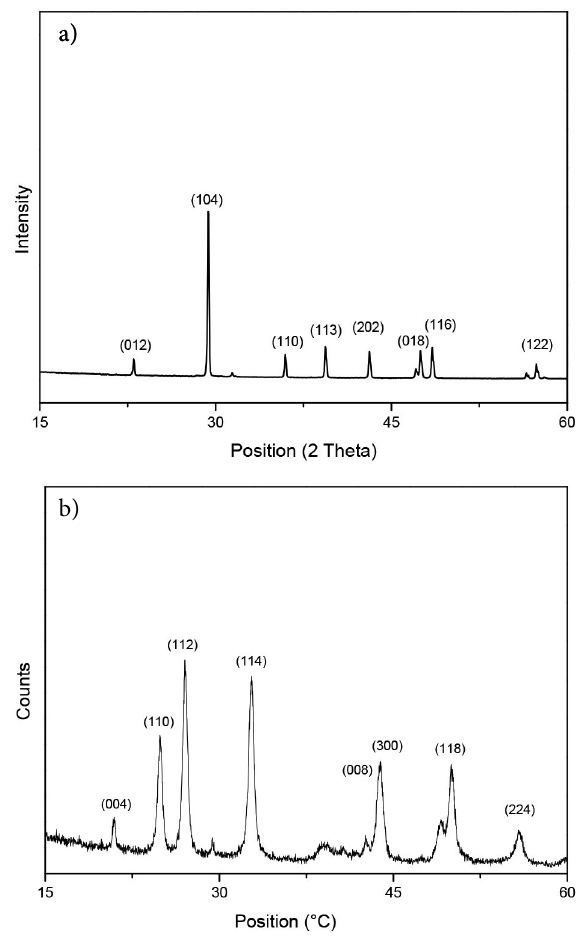
Figure 2. X-ray diffraction patterns of CaCO 3 obtained in the (a) absence and (b) presence of